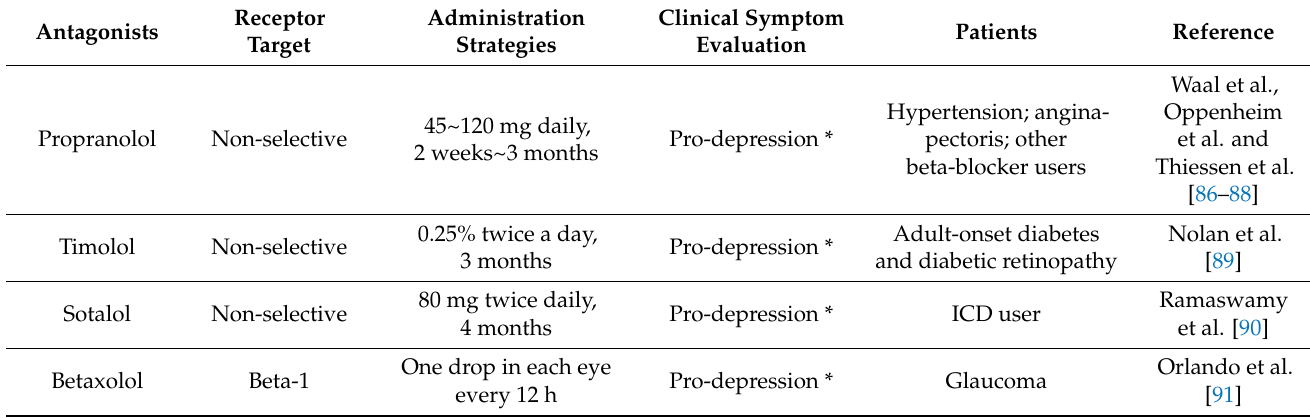
Table 5. Beta-adrenoceptor antagonists tested in human studies and clinical